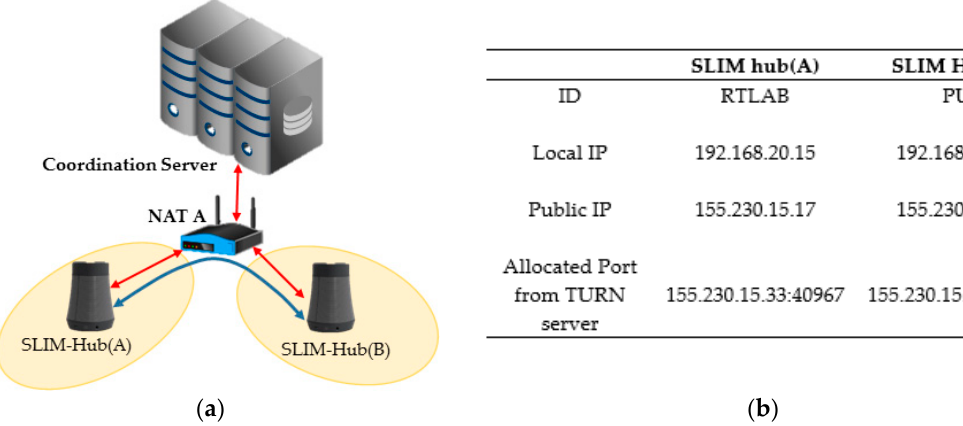
Figure 19. Connectivity environments of same NAT. ( a ) Configuration of experiment; ( b ) A list of SLIM hub’s ID and IP information.